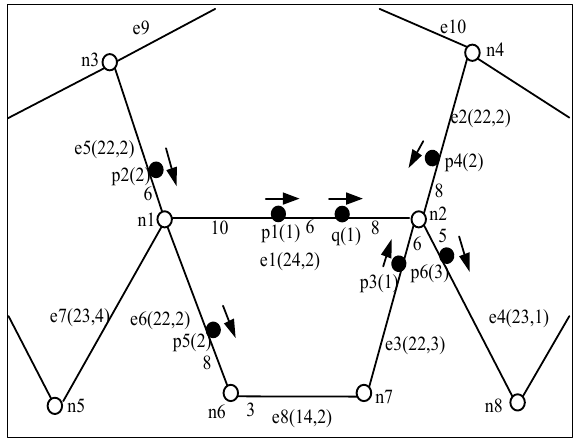
Figure 3. Road network at timestamp 0.